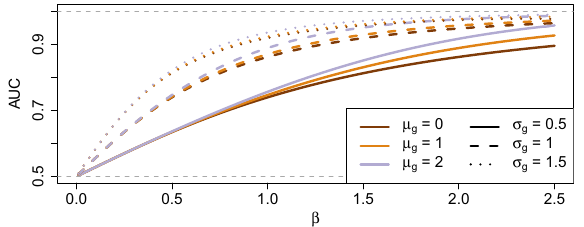
Figure 1. Theoretical AUC as a function of β assuming g i is Gaussian distributed with mean µ g and standard deviation σ g . Different colors correspond to different values of µ g , while line types identify values of σ g . We see that increasing β has the effect of reducing the uncertainty on the random variable s i ( t ) , keeping g i unchanged. Grey dashed lines at AUC = 0.5 and AUC = 1 are guides to the